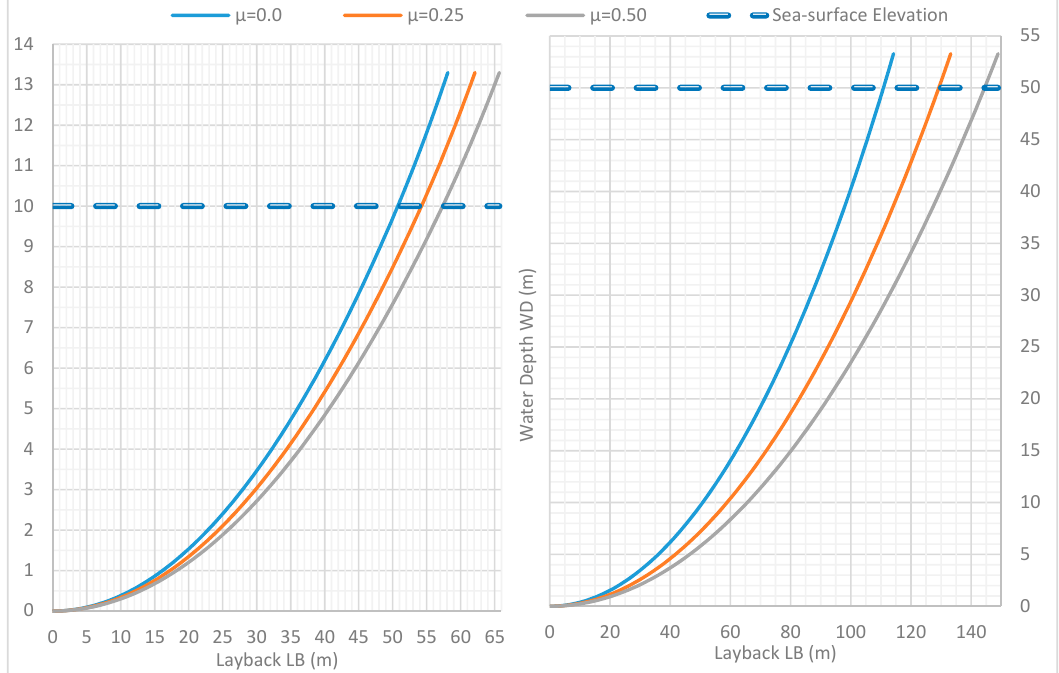
Figure 24. Cable configuration for CS2 assuming different friction coefficients at 10 m and 50 m water depth.